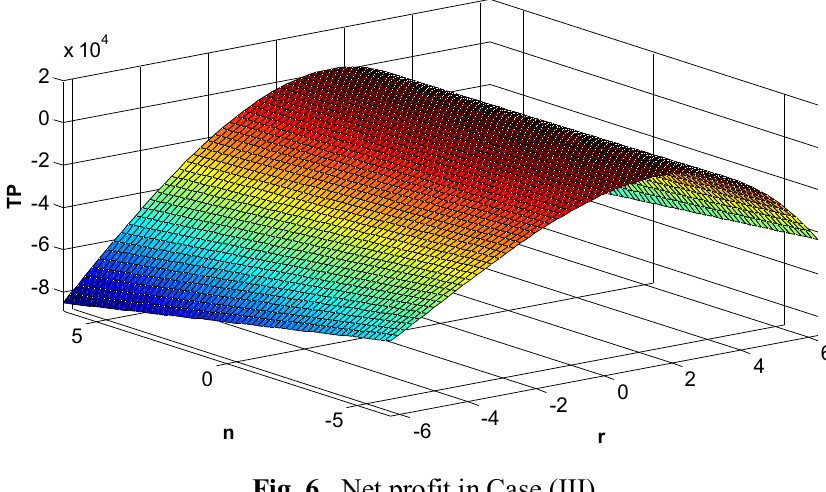
Fig. 6. Net profit in Case (III)